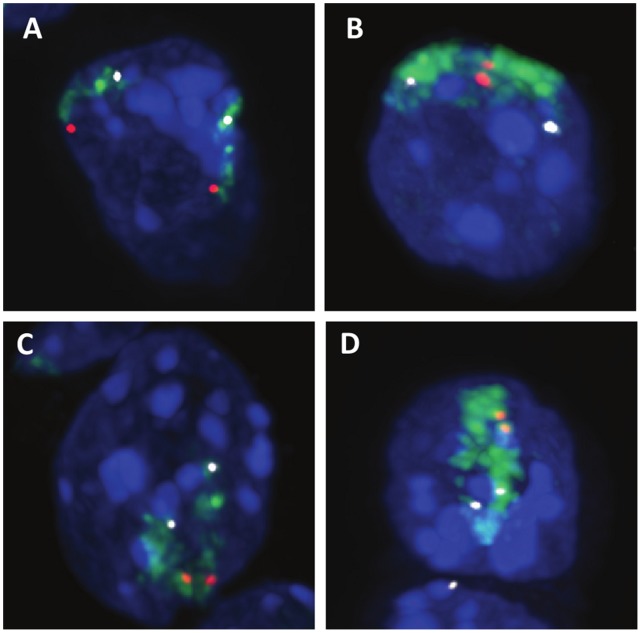
Regional pairing brings chromosome territories close together.3D representation of stacks of confocal images from ES cells. Green: chromosome 7 painting, red: DNA FISH with a probe covering KvDMR near the distal end of chromosome 7, white: DNA FISH with a probe covering Kcnn4 25 Mb away from the proximal end of chromosome 7. FISH signals are mostly located in or close to the edge of their chromosome territory. Most nuclei display two separate chromosome 7 territories (A). When KvDMR signals are close together, the territory arrangements can be ‘touching’ (B) with the proximal ends pointing away from each other, ‘Y-shaped’ with a larger region aligning (C), or ‘aligned’ with most of the chromosome being parallel (D). These arrangements occur with very similar frequencies (n = 9, 8, 9, respectively).